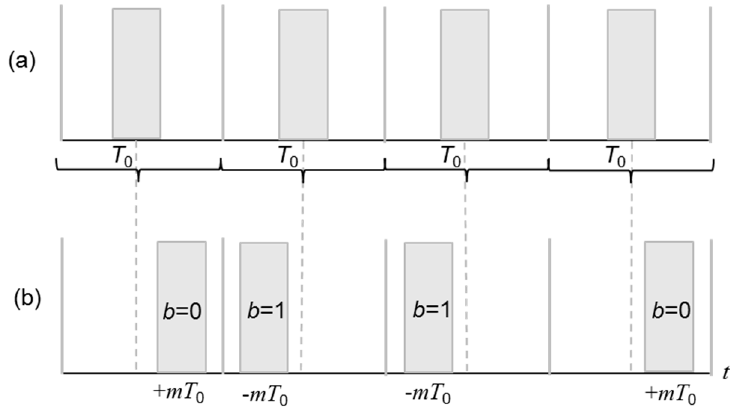
Figure 3. ( a ) Sequence of pulses without modulation and ( b ) sequence of pulse position modulation (PPM) pulses (0110).